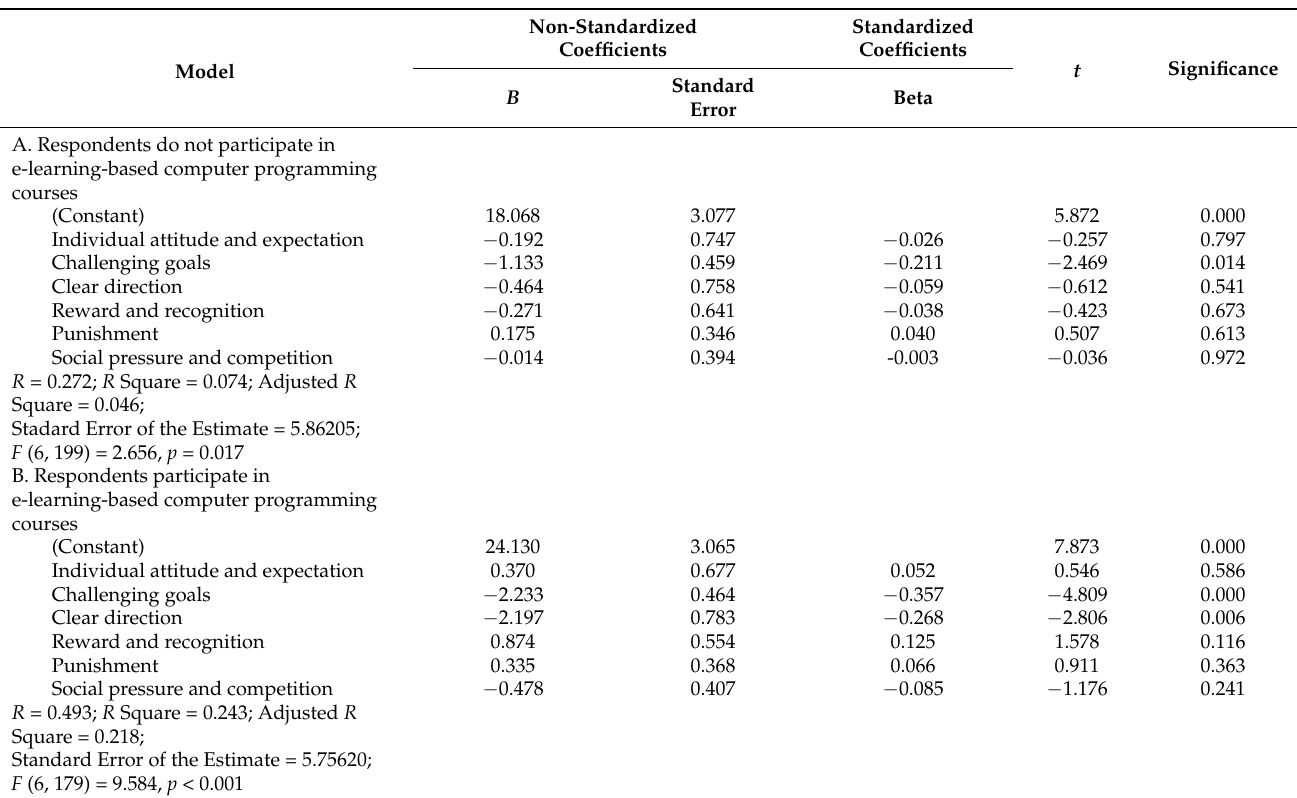
Table 12. Multiple regression models in which the dependent variable is depression and the predictors are learning motivating factors.